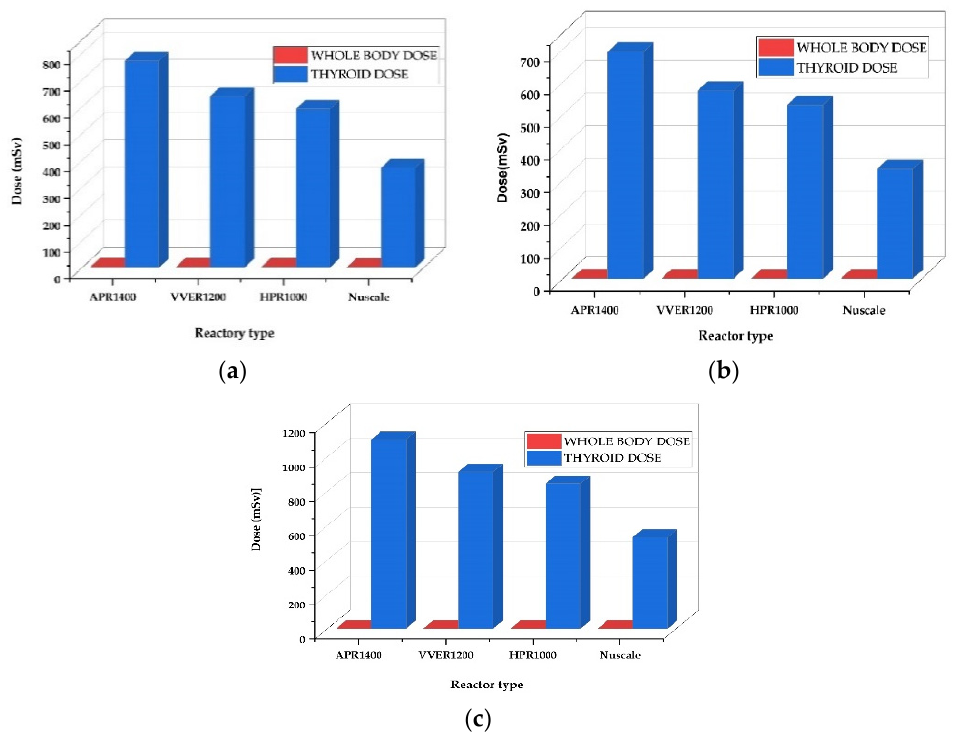
Figure 3. REA thyroid and whole-body dose comparison at the EAB, LPZ, and CR during fuel handling accidents. ( a ) represents doses at the exclusion area boundary. ( b ) represents doses at the low population zone. ( c ) represents doses in the control